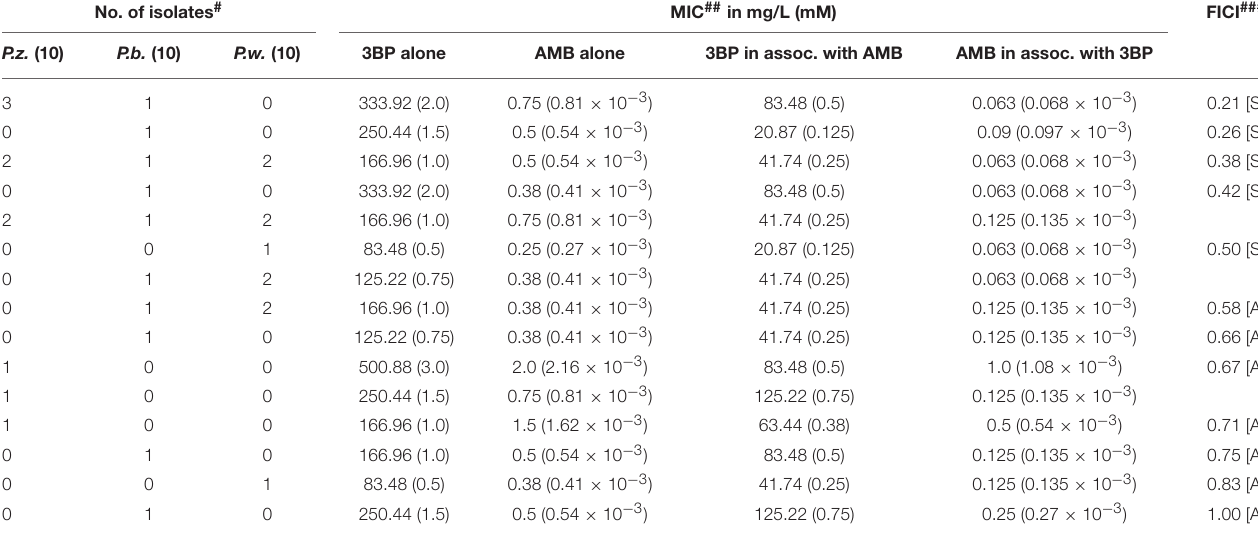
TABLE 3 | Determination of the type of interaction between 3BP and